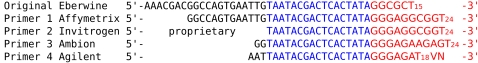
Primers studied. The core T7 polymerase binding site (in blue) and the 3′ spacer sequence (in red) are highlighted.Note that the 3′ spacer sequence in the T7 primers is not identical. In all cases the 3′ spacer is different from the Eberwine T7 primer sequence listed on top.